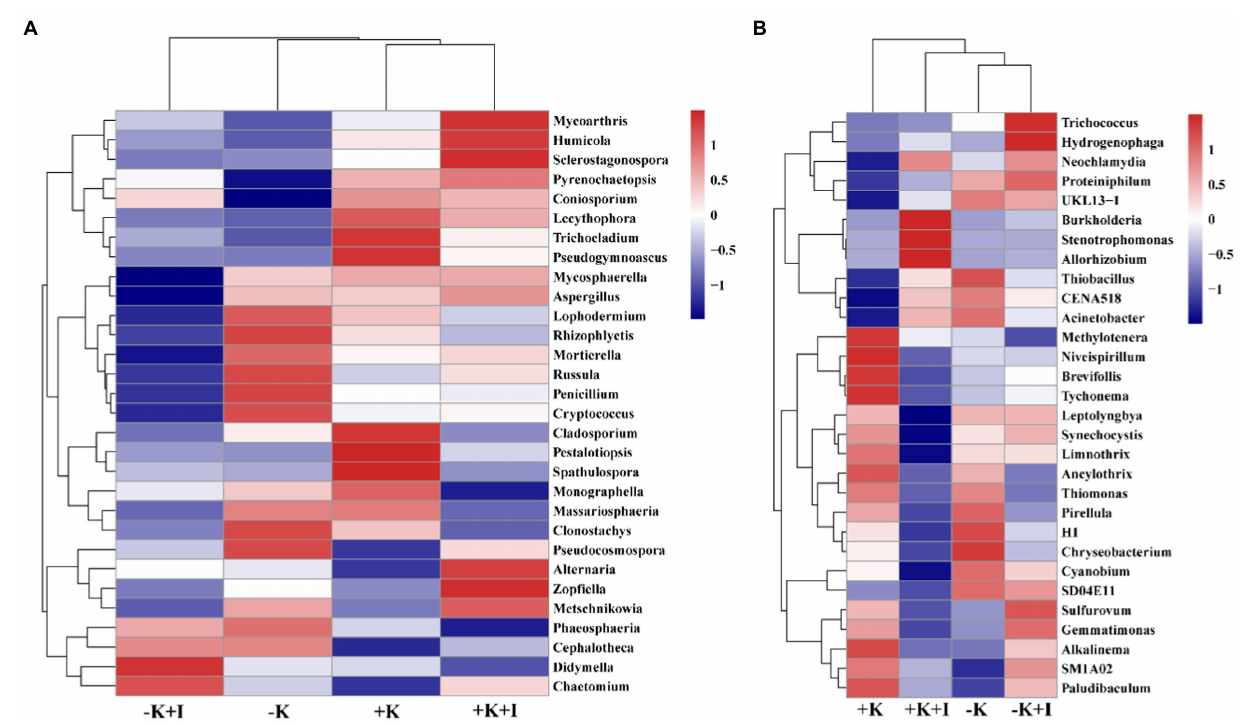
FIGURE 3 | The clustering of fungal (A) and bacteria (B) species abundance after Sarocladium oryzae